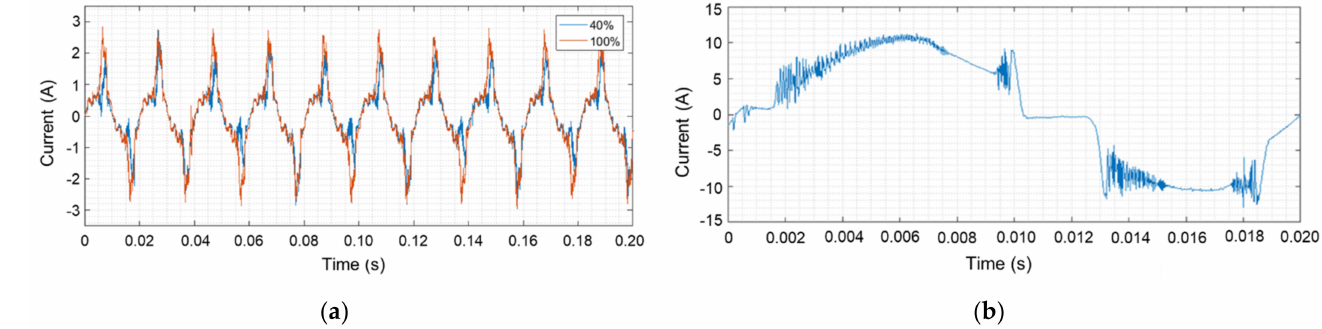
Figure 7. ( a ) Industrial Robot—Currents during rotation of axis 5 at 40% and 100% speed. ( b ) Inrush current signal of the industrial robot after activation with dominant harmonic components up to 10